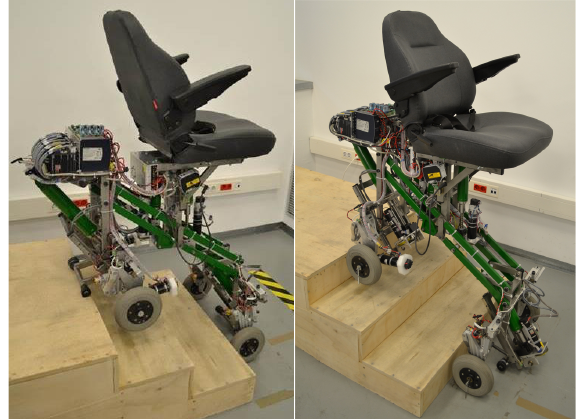
Figure 1. The proposed Stair-Climbing Mobility System (SCMS) is characterized by the fact that it can climb up and down stairs of different sizes and maintain a stable equilibrium on the stair at all times without assistance. It is also characterized by the fact that it can estimate the size of the stair using laser distance sensors and generate safe and comfortable trajectories for the central platform when carrying a user.